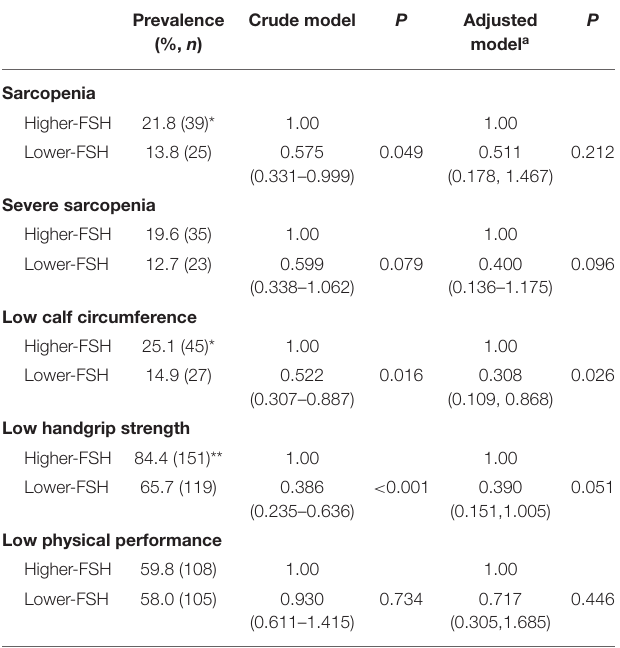
TABLE 3 | Multivariate-adjusted logistic regression analyses of associations between follicle-stimulating hormone (FSH) levels and sarcopenia, severe sarcopenia, and individual sarcopenia components.